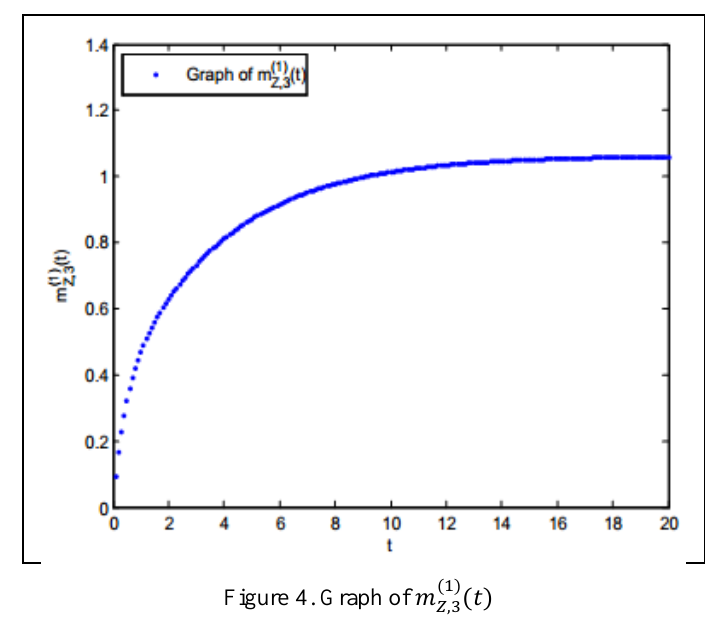
Figure 4. Graph of 𝑚 𝑍,3(1) (𝑡)